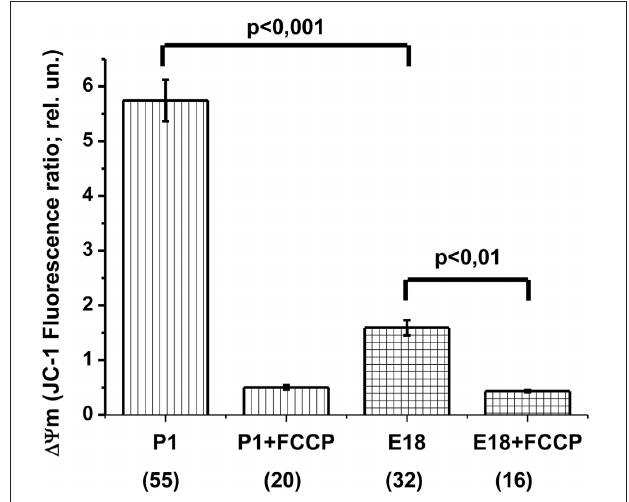
FIGURE 6 | Hippocampal neurons isolated from the embryos have a lower mitochondrial potential ( (cid:2)(cid:3) m) compared to neurons from newborn rats. The values of (cid:2)(cid:3) m as measured by the ratiometric probe JC-1, calculated as the ratio of fluorescence intensities at 640 ± 30nm and 525 ± 20nm (640/525), with excitation at 485nm. Labels P1, P1 + FCCP, E18, and E18 + FCCP indicate postnatal (P1) and embryonic (E18) cultures before and after the protonophoreFCCP (1 μ M) addition. The number of cells utilized to prepare the histogram is shown in